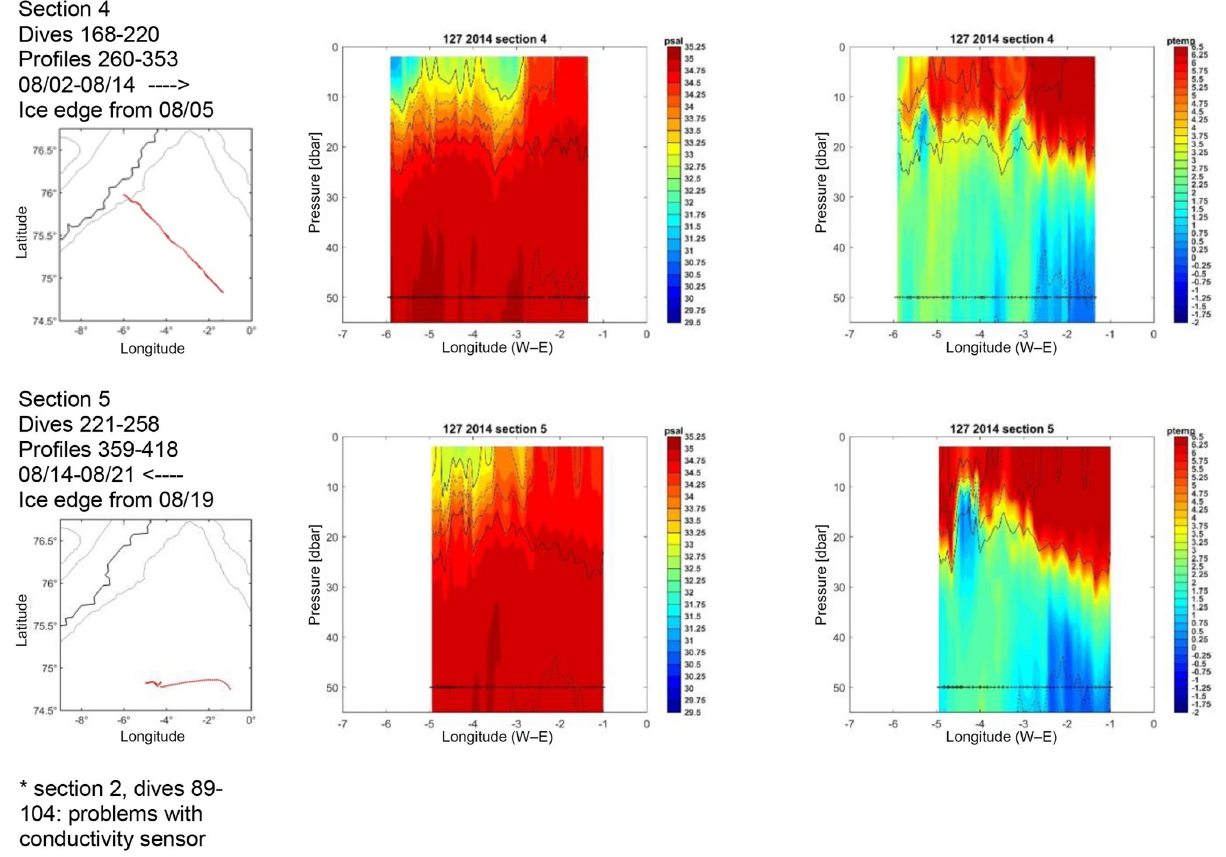
Figure 8. Sections: 2014, glider 127, sections 1–5. Shown is the upper 55m of the water column. Left column: information and map extract with location of the profiles and ice edge for the time span of the section (see Sect. 2.4 for details); numbers of original dives on the section, numbers of profiles from the final data set on the section, time span, and direction of the section: < --- east to west, --- > west to east. Middle/right column: salinity/potential temperature. Both plots are overlaid with the sigma-contours 26.0, 26.5, 27.0, 27.5 and 28.0kgm − 3 (see legend for line style in Fig. 7). Stars at 50m depth mark the position of the profiles on the section before the gridding of the data in the horizontal took place. For section 2 many profiles are missing because of problems with the conductivity